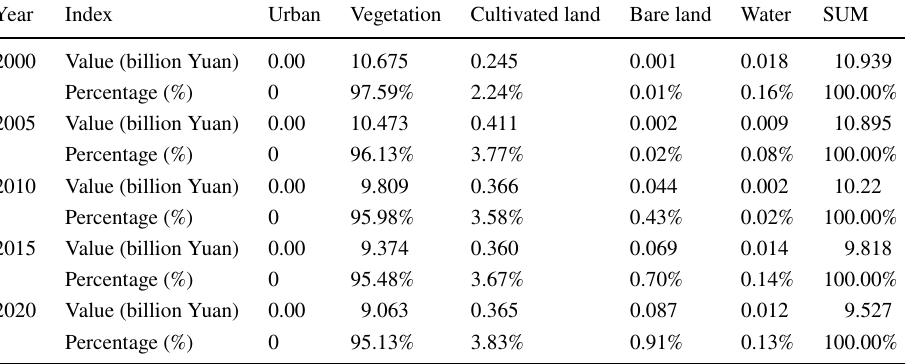
Table 6 Ecosystem service values in the Shengli coalfield from 2000–2020 (billion Yuan)